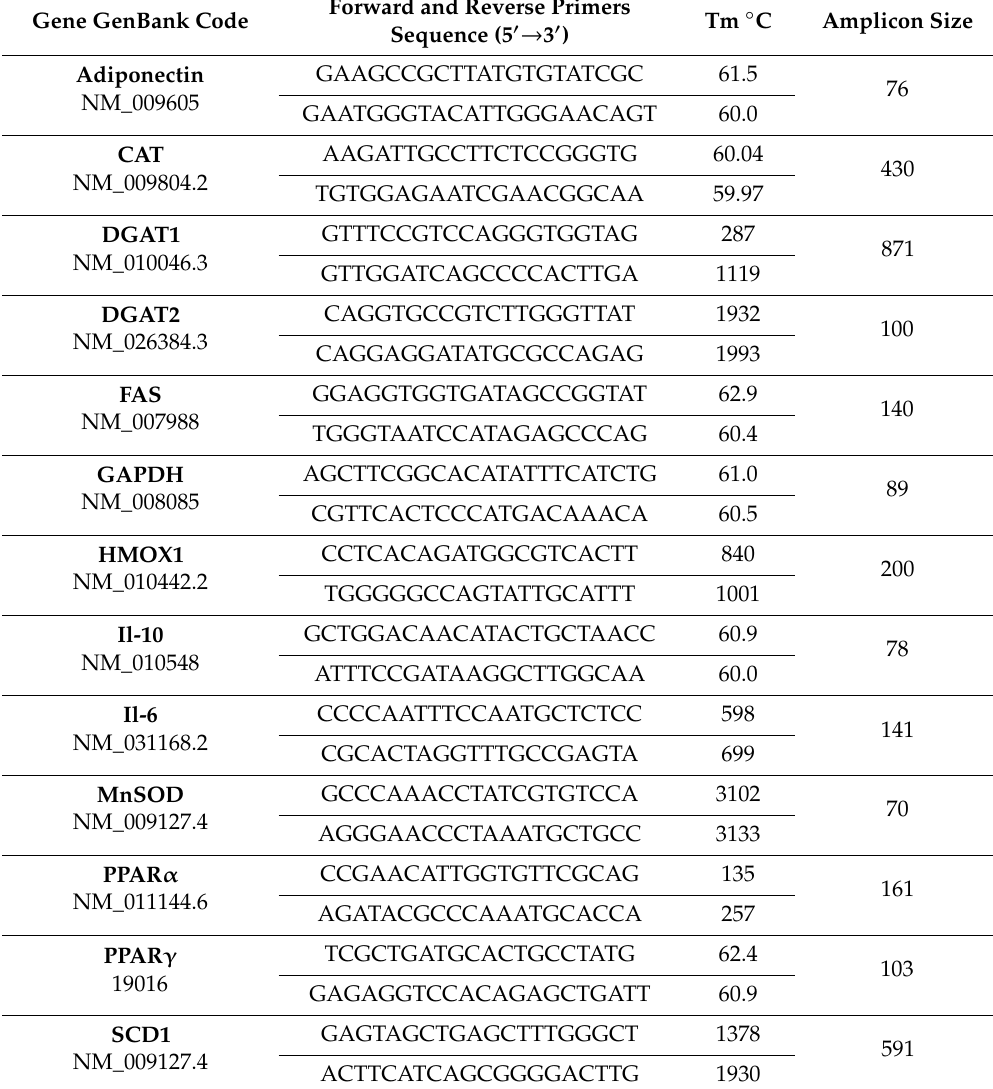
Table 2. Primers used in this